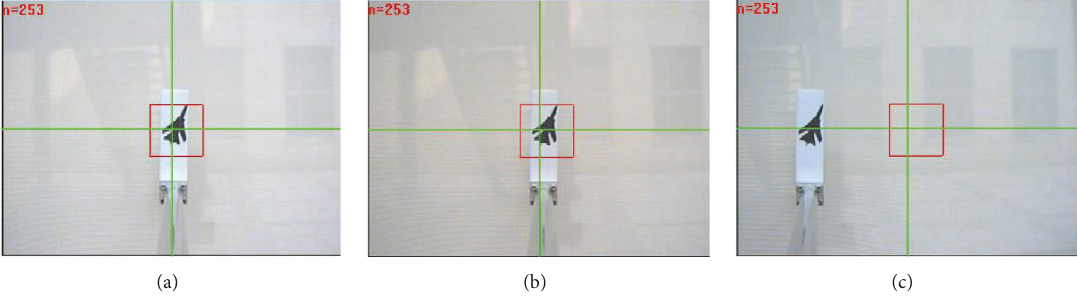
Figure 19: The process of the seeker tracking the target when 𝑘 = 30